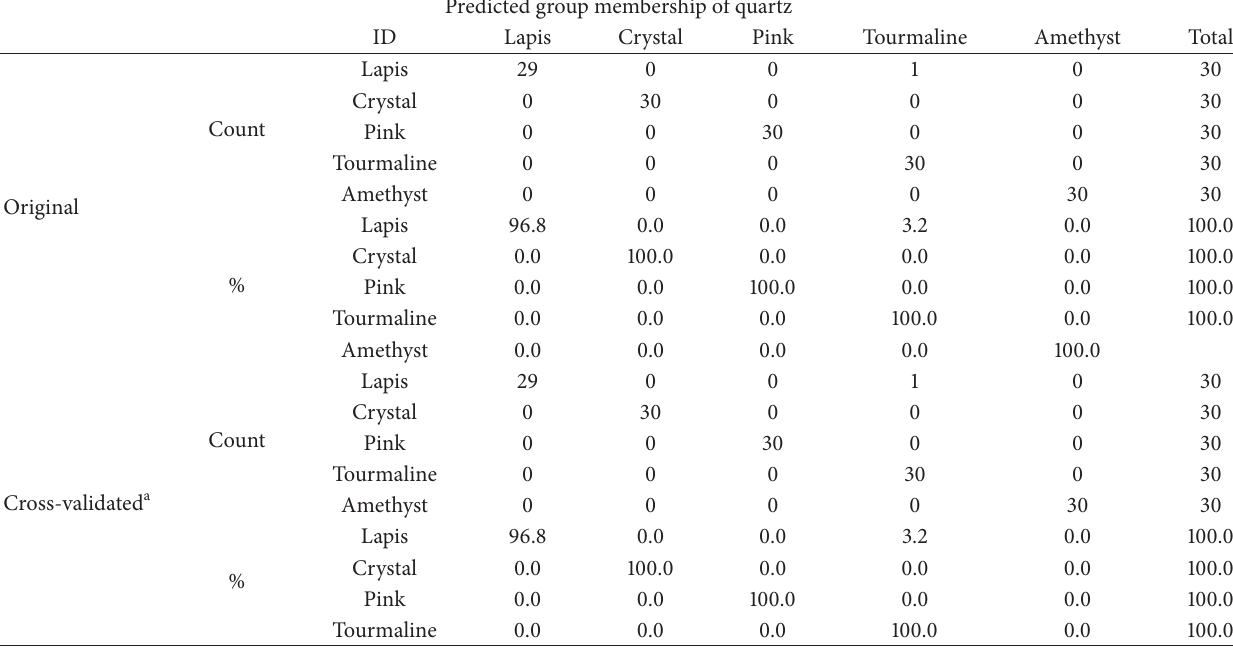
Table 4: Predicted group membership of quartz and its